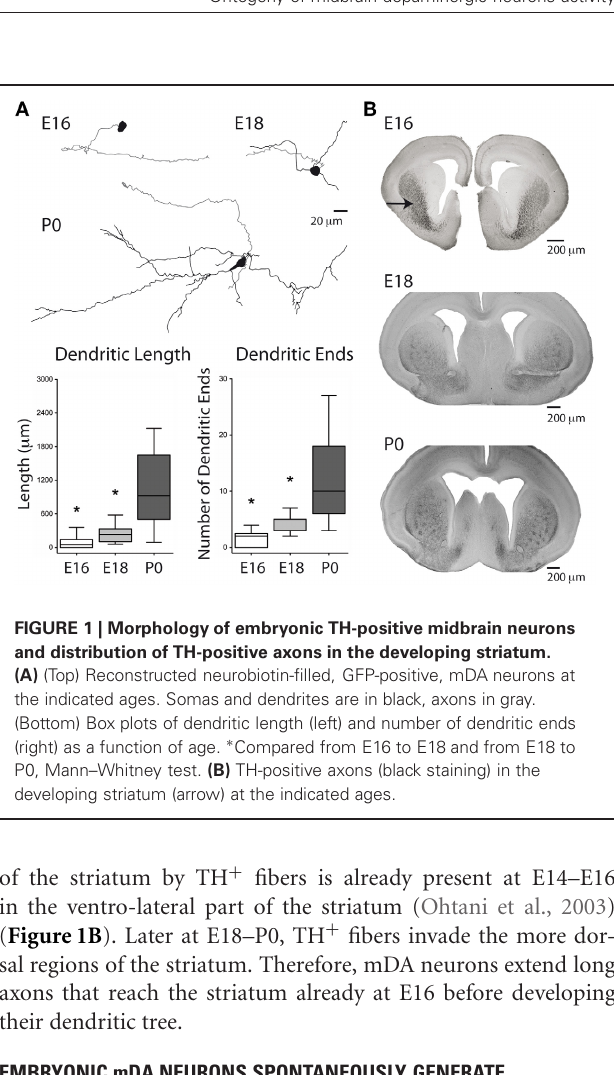
of the striatum by TH + fibers is already present at E14–E16 in the ventro-lateral part of the striatum (Ohtani et al.,